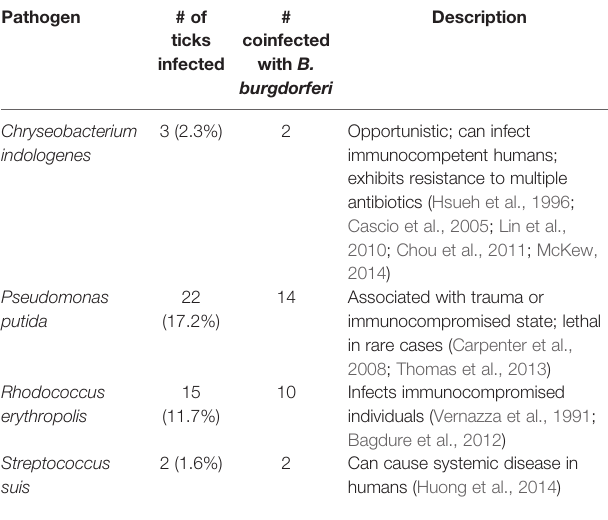
TABLE 2 | Microbiome analysis detected bacterial species pathogenic to humans and not previously reported in ticks.